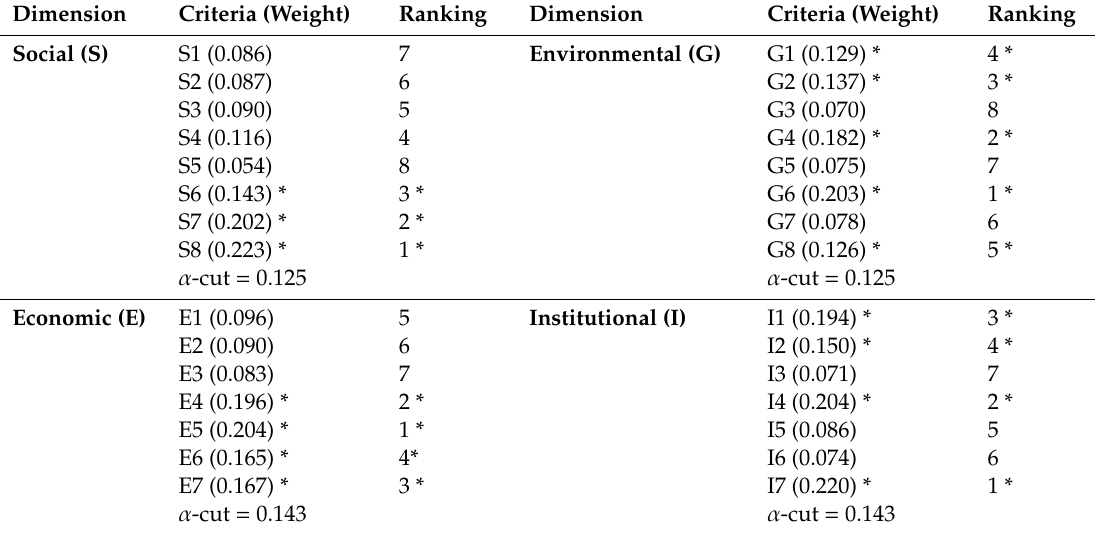
Table 4. Criteria weights obtained through Bayesian BWM.